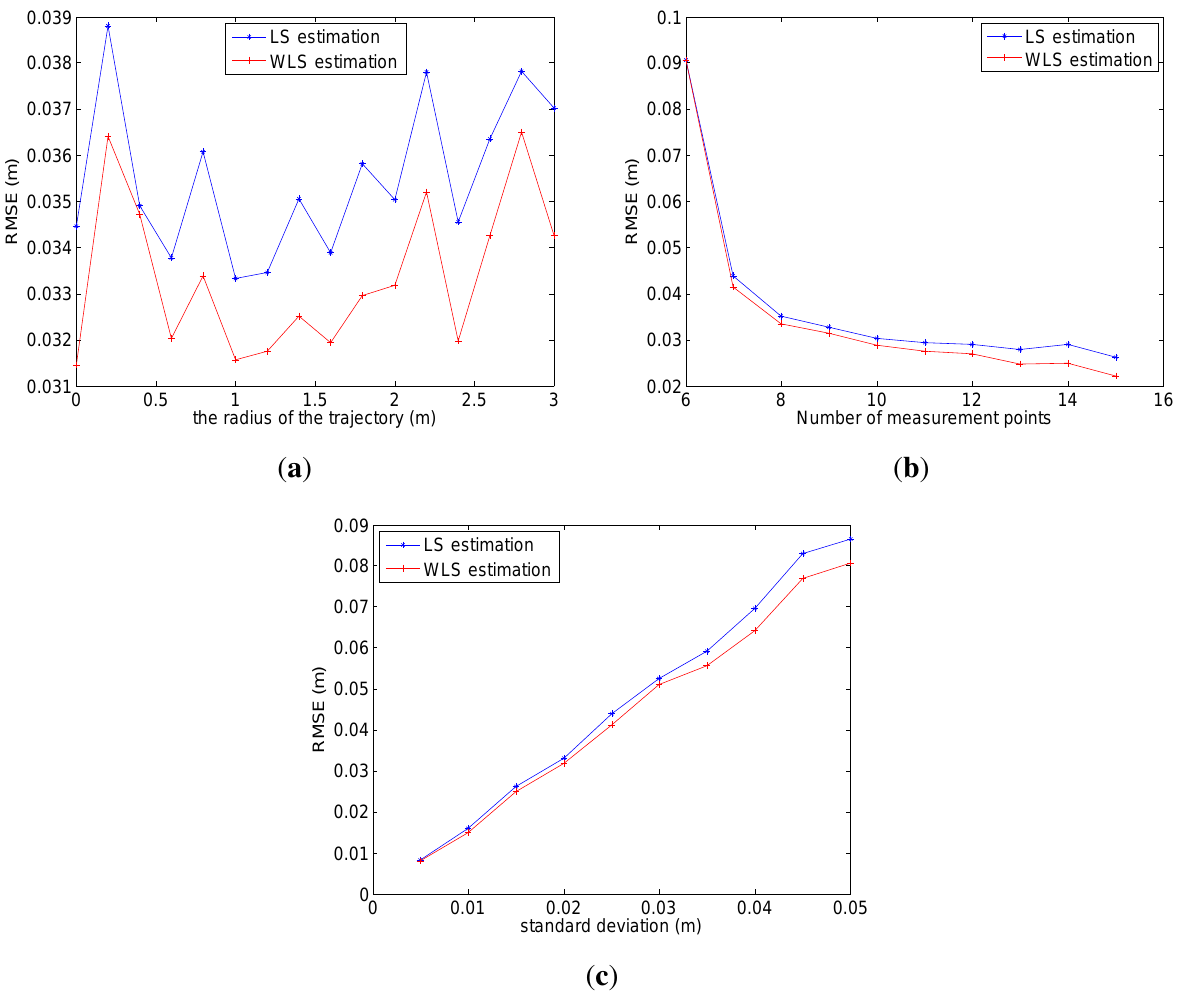
Figure 8. The illustration of impacts. ( a ) The impact of the radius of the spiral trajectory; ( b ) the impact of the number of measurement points; ( c ) the impact of environment